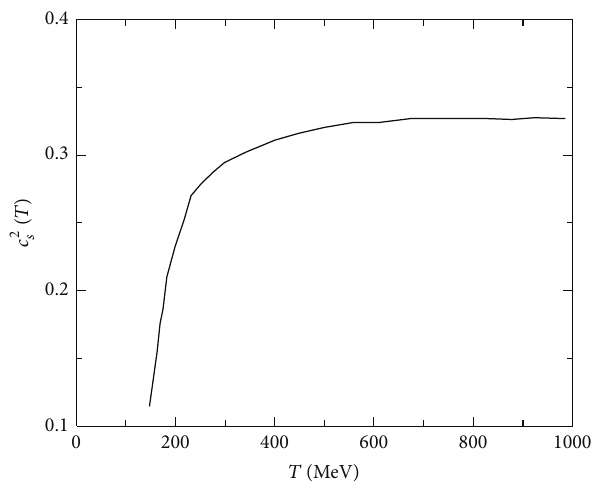
Figure 6: Velocity of sound squared as a function temperature [8]. used inputs from lattice QCD (LQCD) to minimize the model dependence of the results.